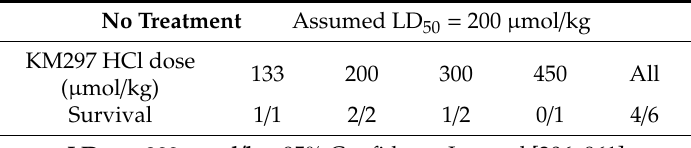
Table 8. LD 50 estimation of KM297 HCl using the up-and-down method for injected intraperitoneally mice. An LD 50 value of 200 µ mol / kg is initially assumed at the beginning of the experiment with sigma = 0.0176 ( = log 1.5). The LD 50 value was calculated using the AOT 425 Pgm